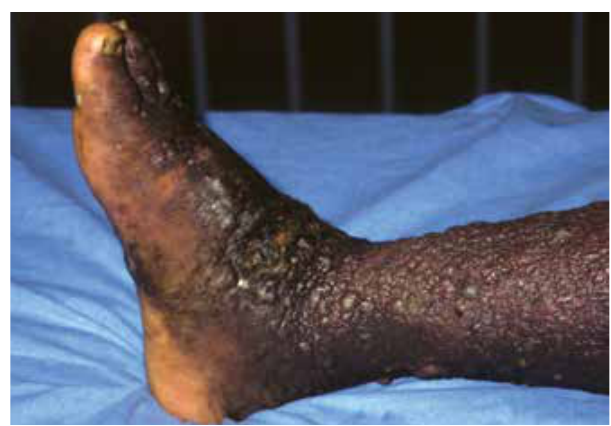
Figure 13: Extensive Kaposi’s sarcoma, with lymphoedema and multiple